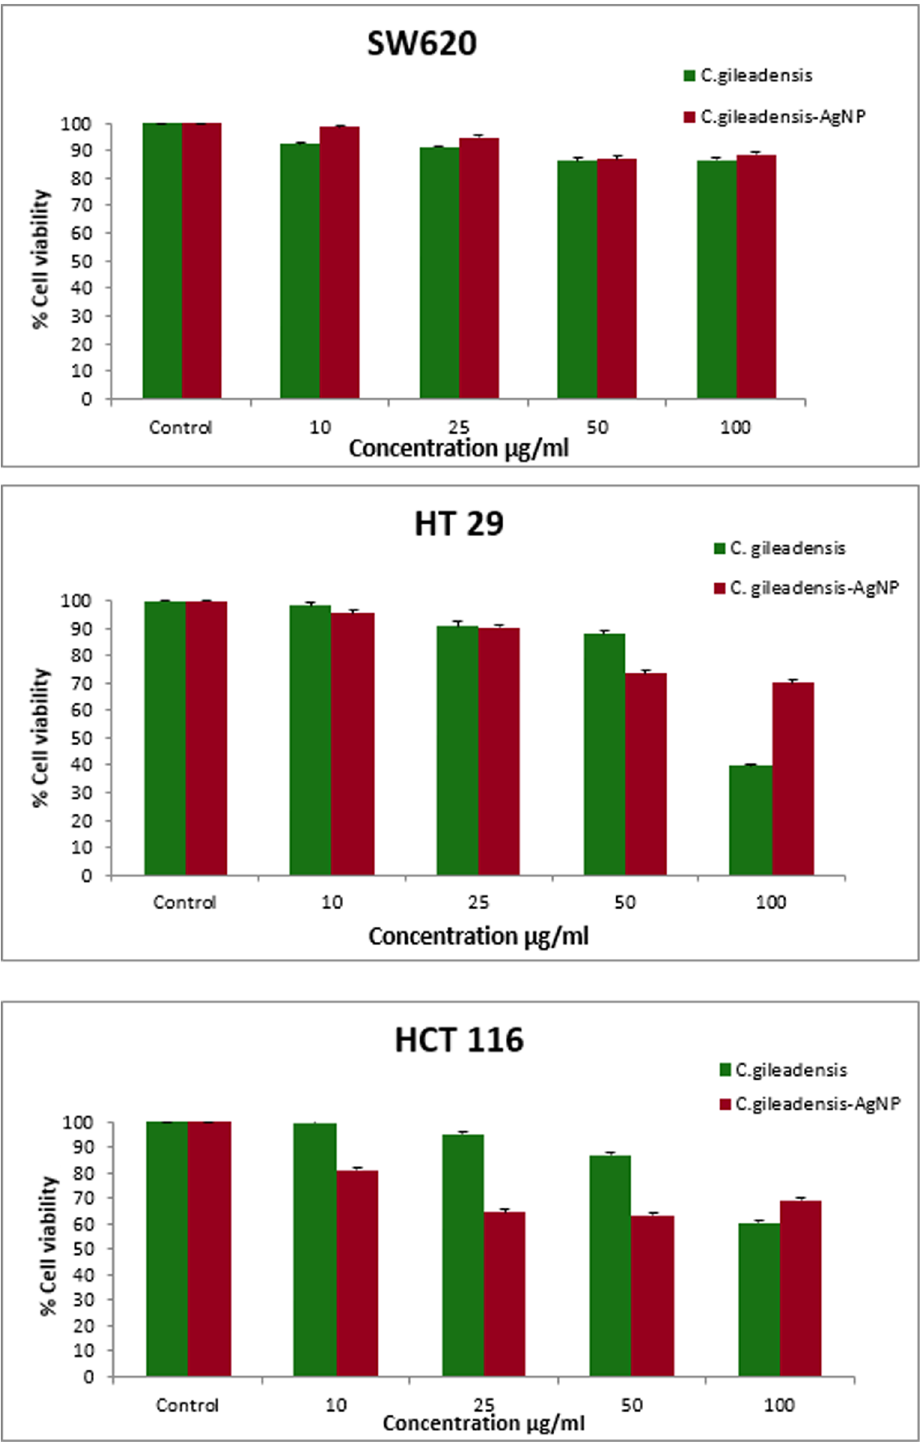
Figure 4: Cytotoxicity of C. gileadensis extracts and C. gileadensis AgNPs ’ extract against human colon cancer cell lines HTC116, HT29, and